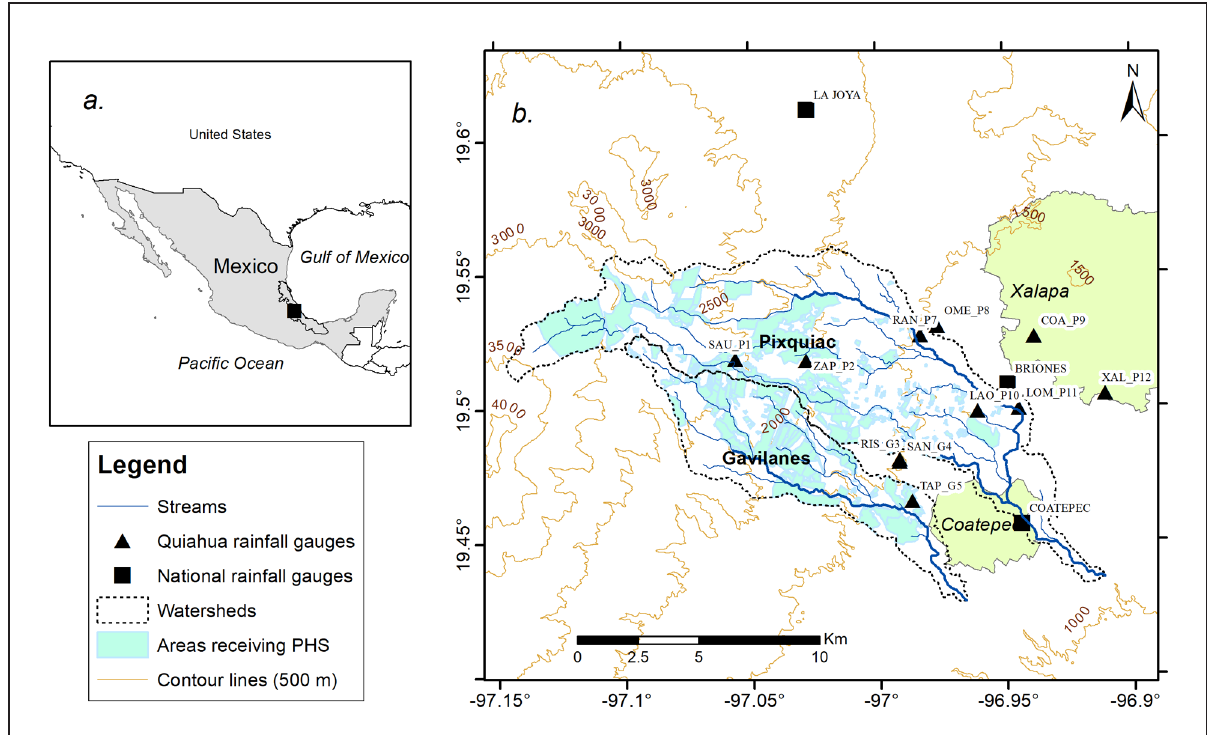
Figure 1: (a) Study area location in central Mexico and (b) locations of existing national rainfall gauges and new gauges associated with this project. Also shown are locations of areas receiving payment for hydrologic services (PHS) ( blue ) and cities ( green ) that depend on water supplies from the